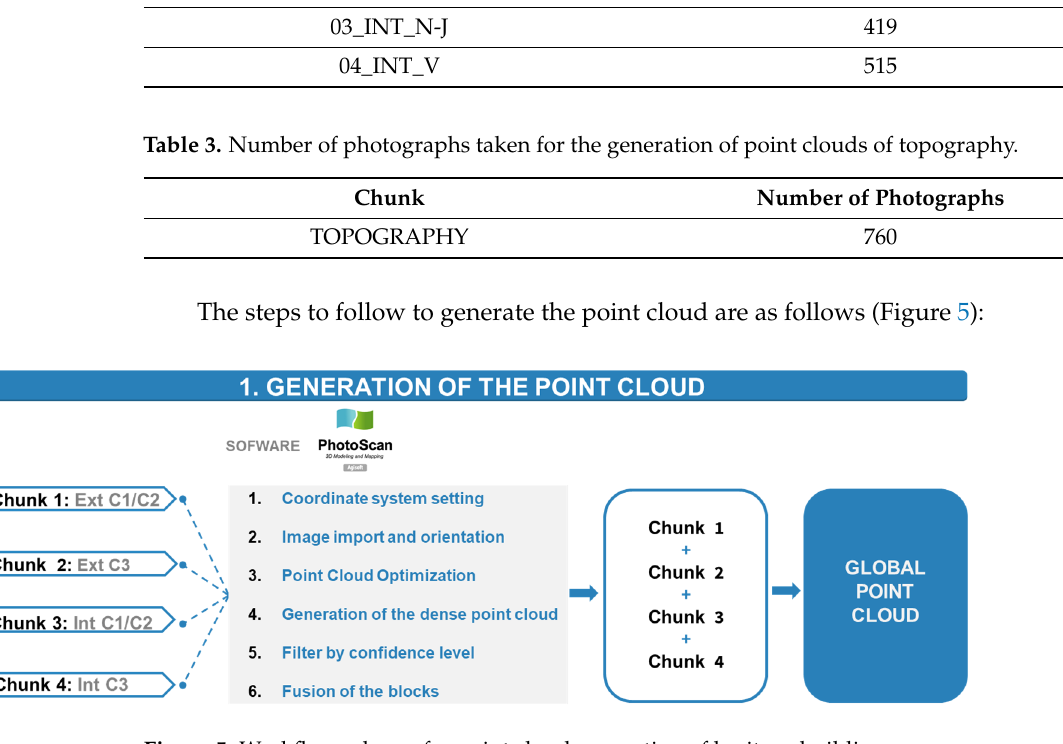
Figure 5. Workflow scheme for point cloud generation of heritage buildings.